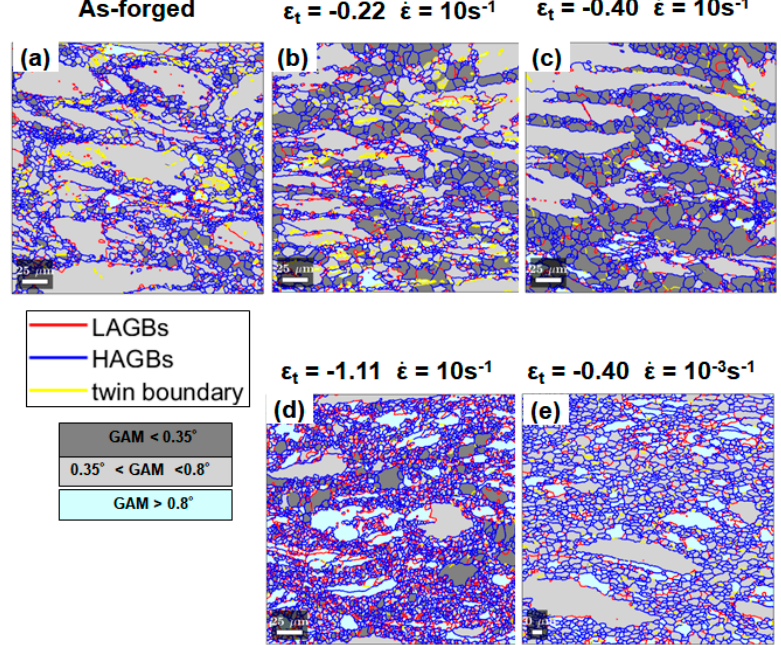
Figure 8. Partitioned GAM maps with threshold values of 0.35° and 0.8° for the microstructures in: ( a ) as-forged state, deformed state ( b ) with ε t of − 0.22 at (cid:2013)(cid:4662) of 10 s − 1 , ( c ) with ε t of − 0.40 at (cid:2013)(cid:4662) of 10 s − 1 , ( d ) with ε t of − 1.11 at (cid:2013)(cid:4662) of 10 s − 1 , and ( e ) with ε t of − 0.40 at (cid:2013)(cid:4662) of 10 − 3 s − 1 .